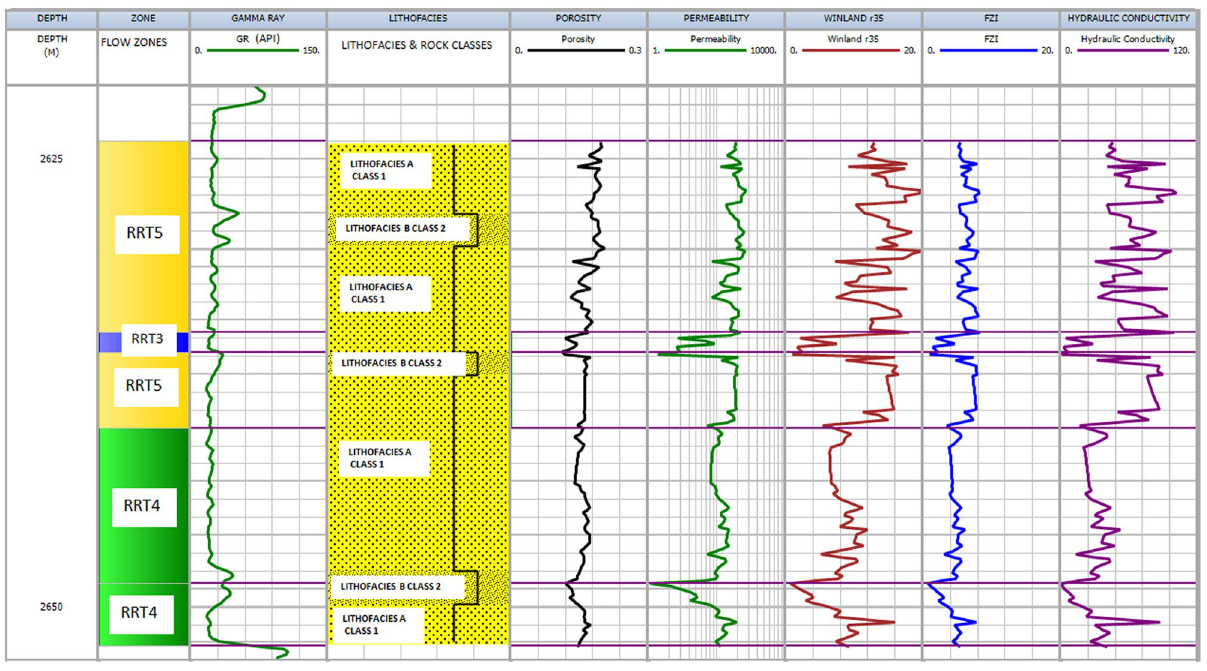
Figure 9. Shows the results for well OW1. Track 1 shows the measured depth. Displayed in tracks 2–9 are flow zones, Gamma ray log, lithofacies, porosity, permeability, Winand r35, Flow zone indicator, and hydraulic conductivity.